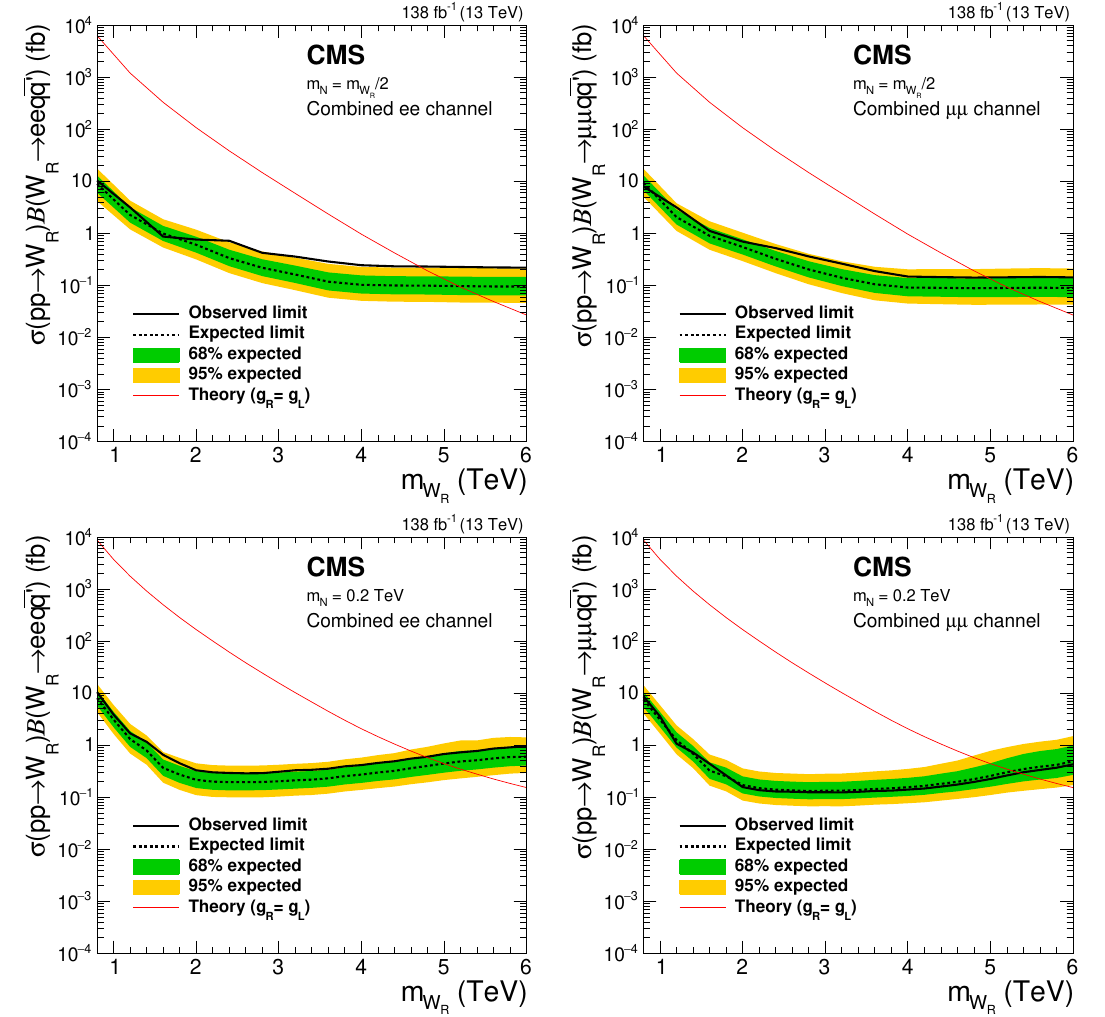
Figure 6 . The expected (black dashed line) and the observed (black solid line) 95% CL upper limits on the product of the cross section for W electron channel (left) and muon channel (right) from the combination of the resolved and boosted categories. The plots in the upper (lower) row are the results for the m mass point, which correspond to the resolved (boosted) W (outer) bands indicate the 68 and 95% coverage of the expected upper limits. The red solid lines represent the values expected from the theory